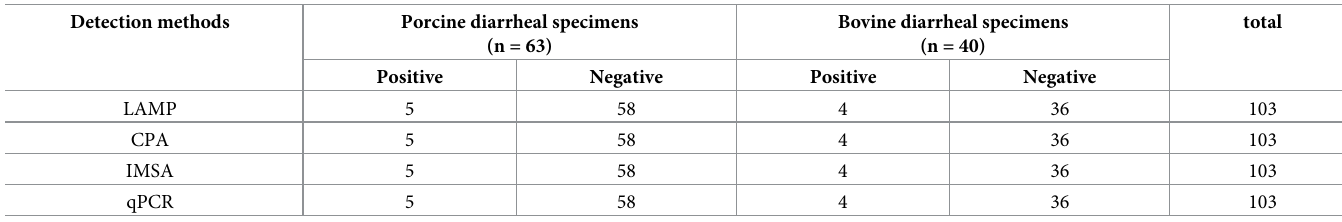
Table 3. Detection results for clinical samples. Detection